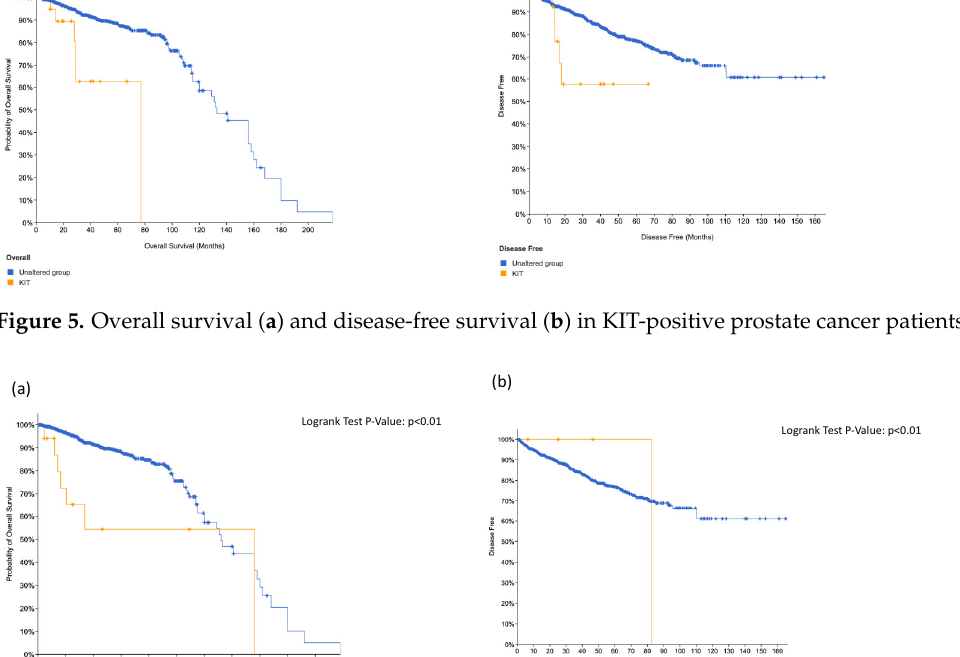
Figure 4. Overall survival ( a ) and disease-free survival ( b ) in ABL1-positive prostate cancer patients.